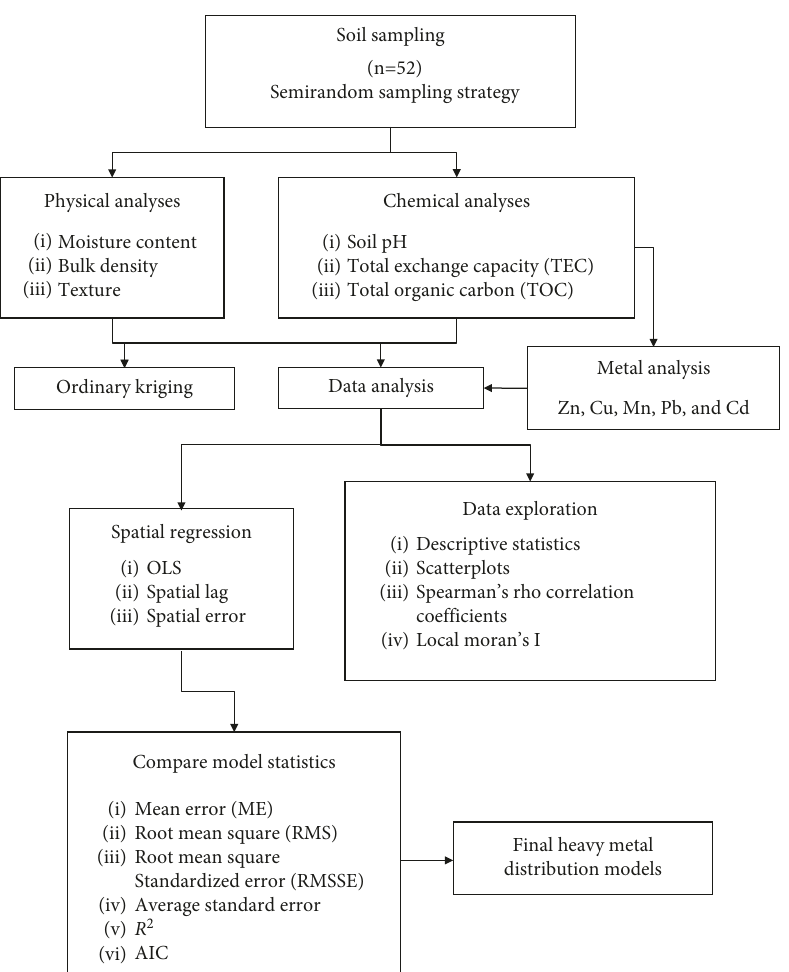
Figure 2: Physical and chemical analyses of soil samples were used to develop spatial prediction models for PTM Table 1: Explanatory and response variables. Explanatory variables